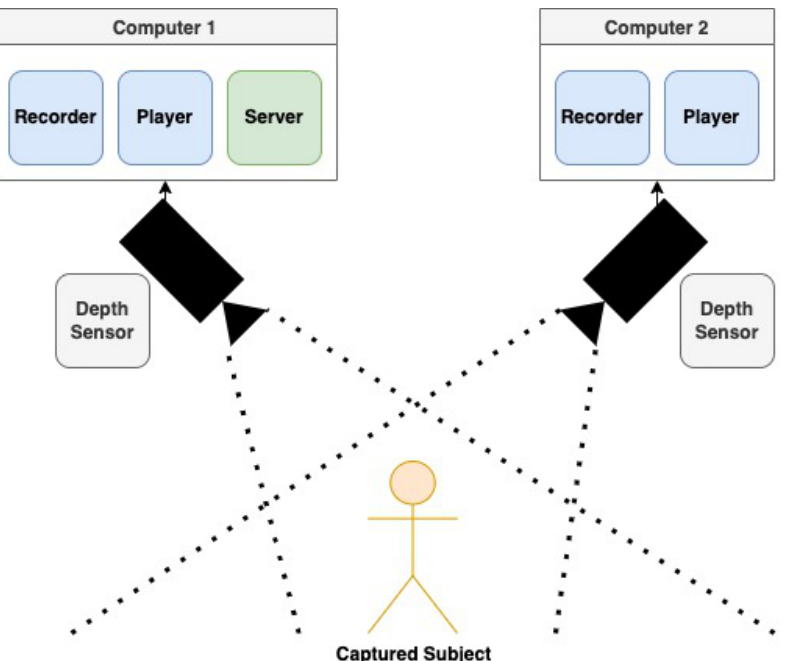
Figure 3. The multi-camera tracking system setup includes two depth sensors allowing the capture of the full range of patient motion, as well as enabling data merging to reduce noise and skeleton